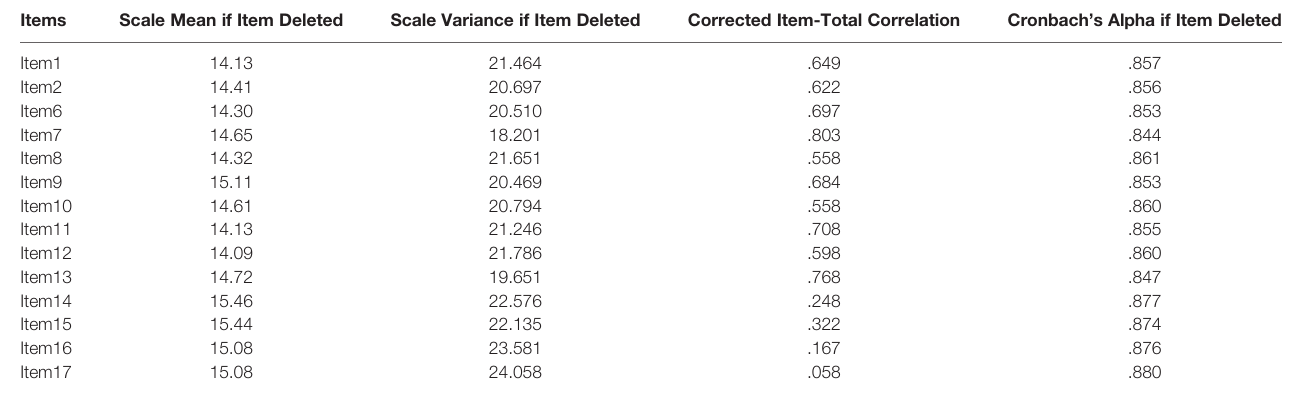
TABLE 6 | Cronbach ’ s a , if any individual item was deleted.